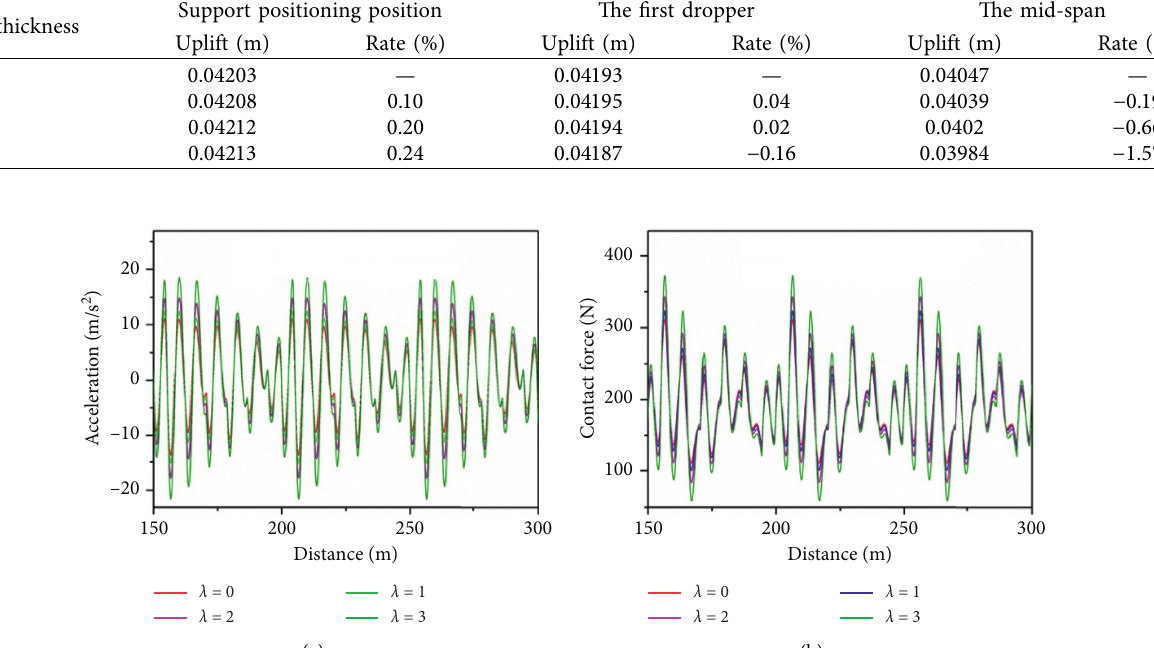
Figure 7: Dynamic characteristics between pantograph and catenary (increased density method). (a) Acceleration. (b) Contact force.